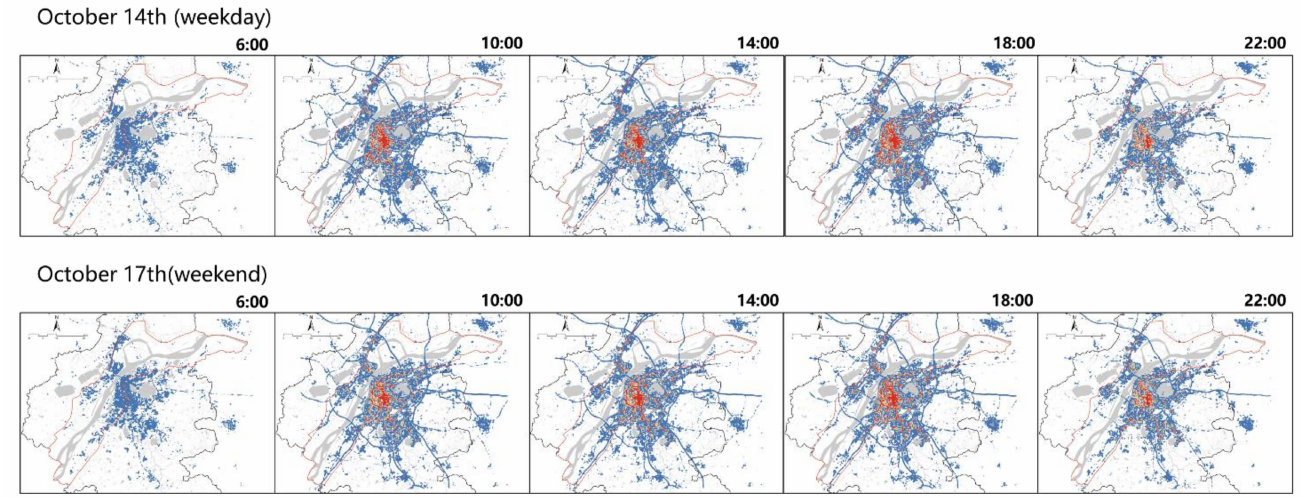
Figure 2. The sample data of BHM data collected on October 14th and October 17th in